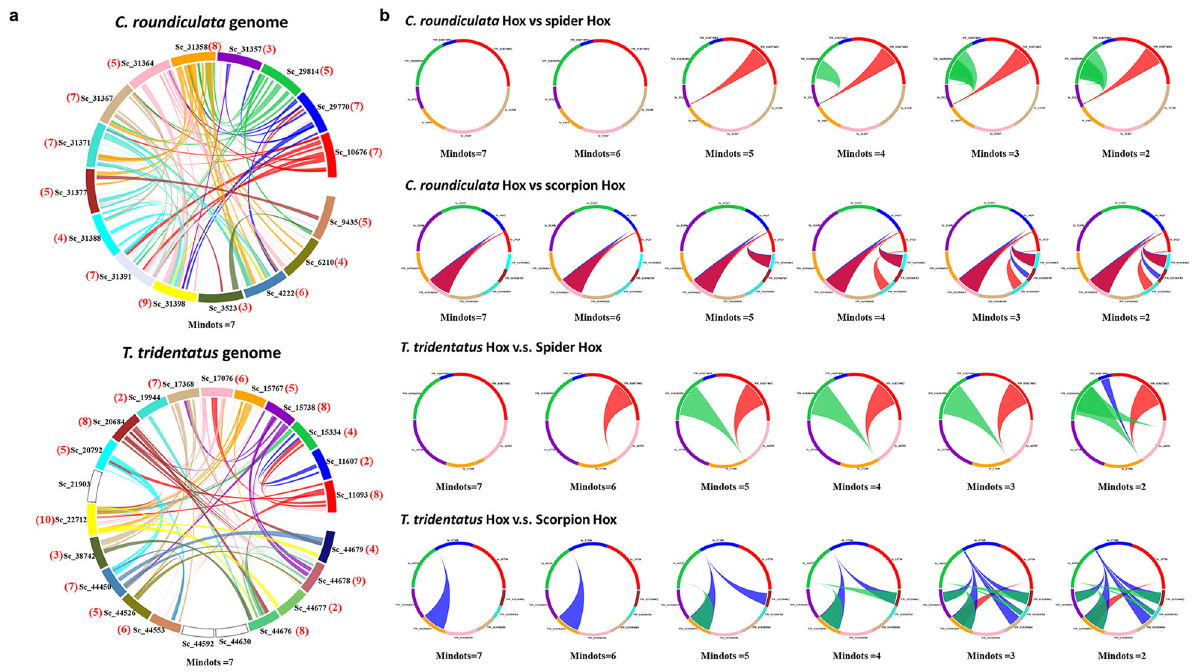
Fig. 3 Syntenic regions between chelicerate genomes. a Synteny between different chromosomes of C. roundiculata and T. tridentatus . Note that the bracketed numbers highlighted in red refer to the numbers of chromosomes that syntenic blocks with that chromosome (counting include its own copy). b Synteny relationships of Hox scaffolds of (Upper panel): C. roundiculata , spider and scorpion; (Lower panel) and T. tridentatus , spider, and